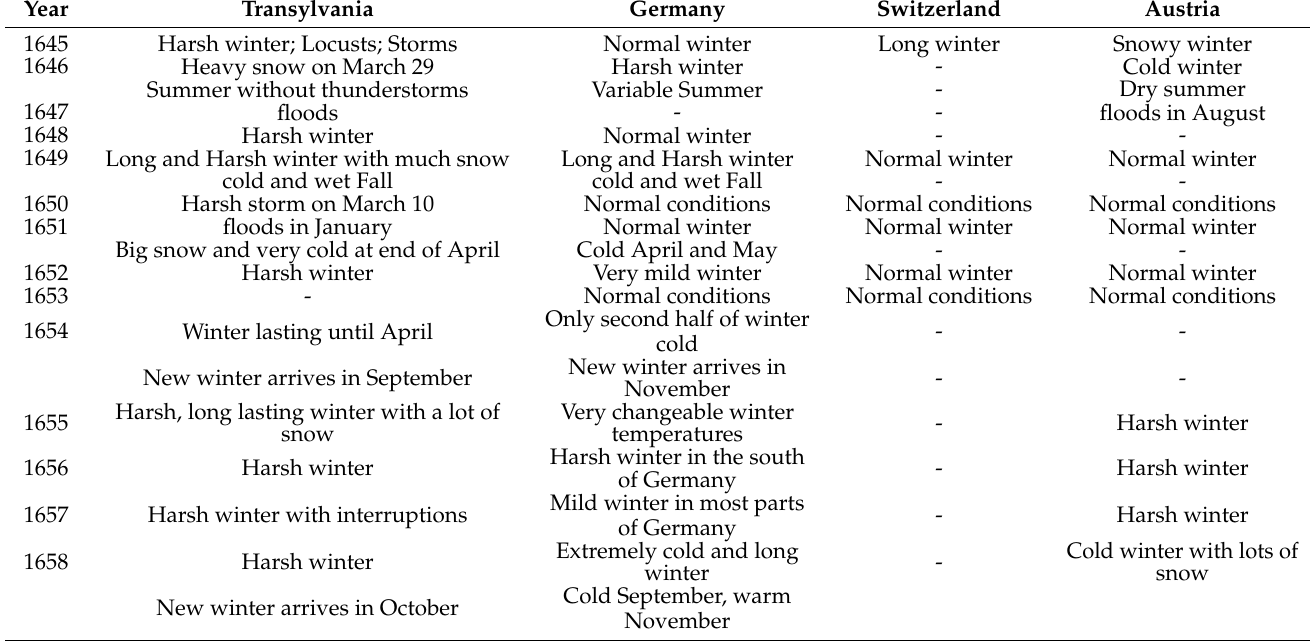
Table 2. Synoptic comparison of weather phenomena for Transylvania, Germany, Switzerland and Austria. All entries are discussed in the text and the respective references are